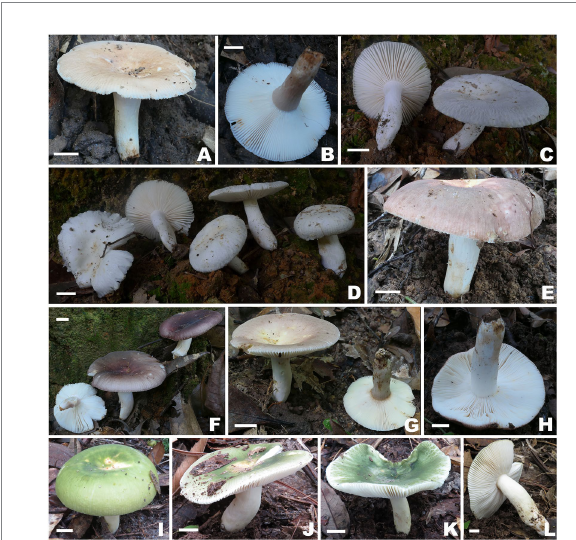
FIGURE 2 Basidiomata of Russula subg. Heterophyllidiae species. (A,B) Russula discoidea (FHMU4847, holotype); (C,D) Russula niveopicta (FHMU958, holotype); (E–H) R. subatropurpurea (E,H) FHMU5454; (F) FHMU4812; (G) FHMU4841; (I–L) R. xanthovirens (I,K) FHMU2002; (J,L) FHMU1986; scale bars = 1 cm; photographs: N. K. Zeng.